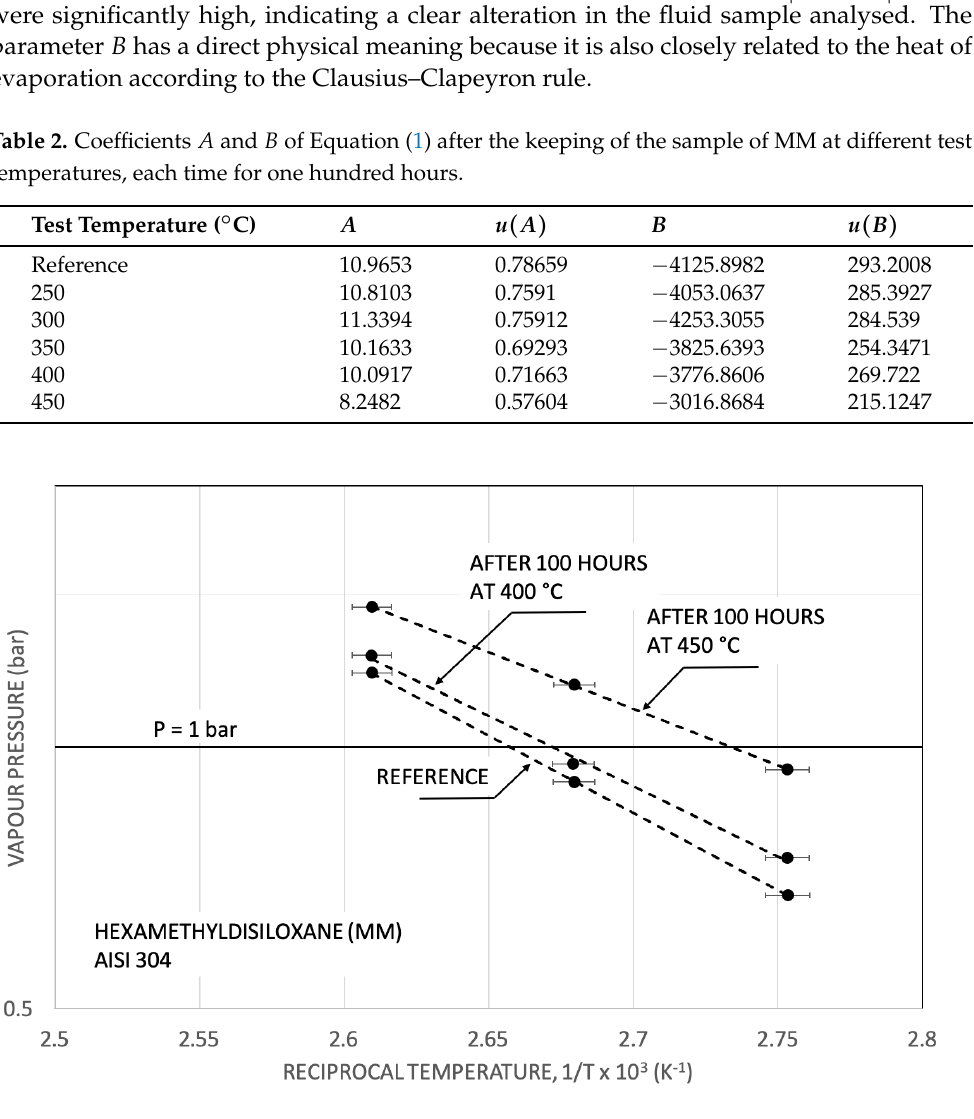
Figure 3. Vapour pressure for hexamethyldisiloxane (MM) near the ambient pressure after the fluid sample remained at three different temperatures for one hundred hours each